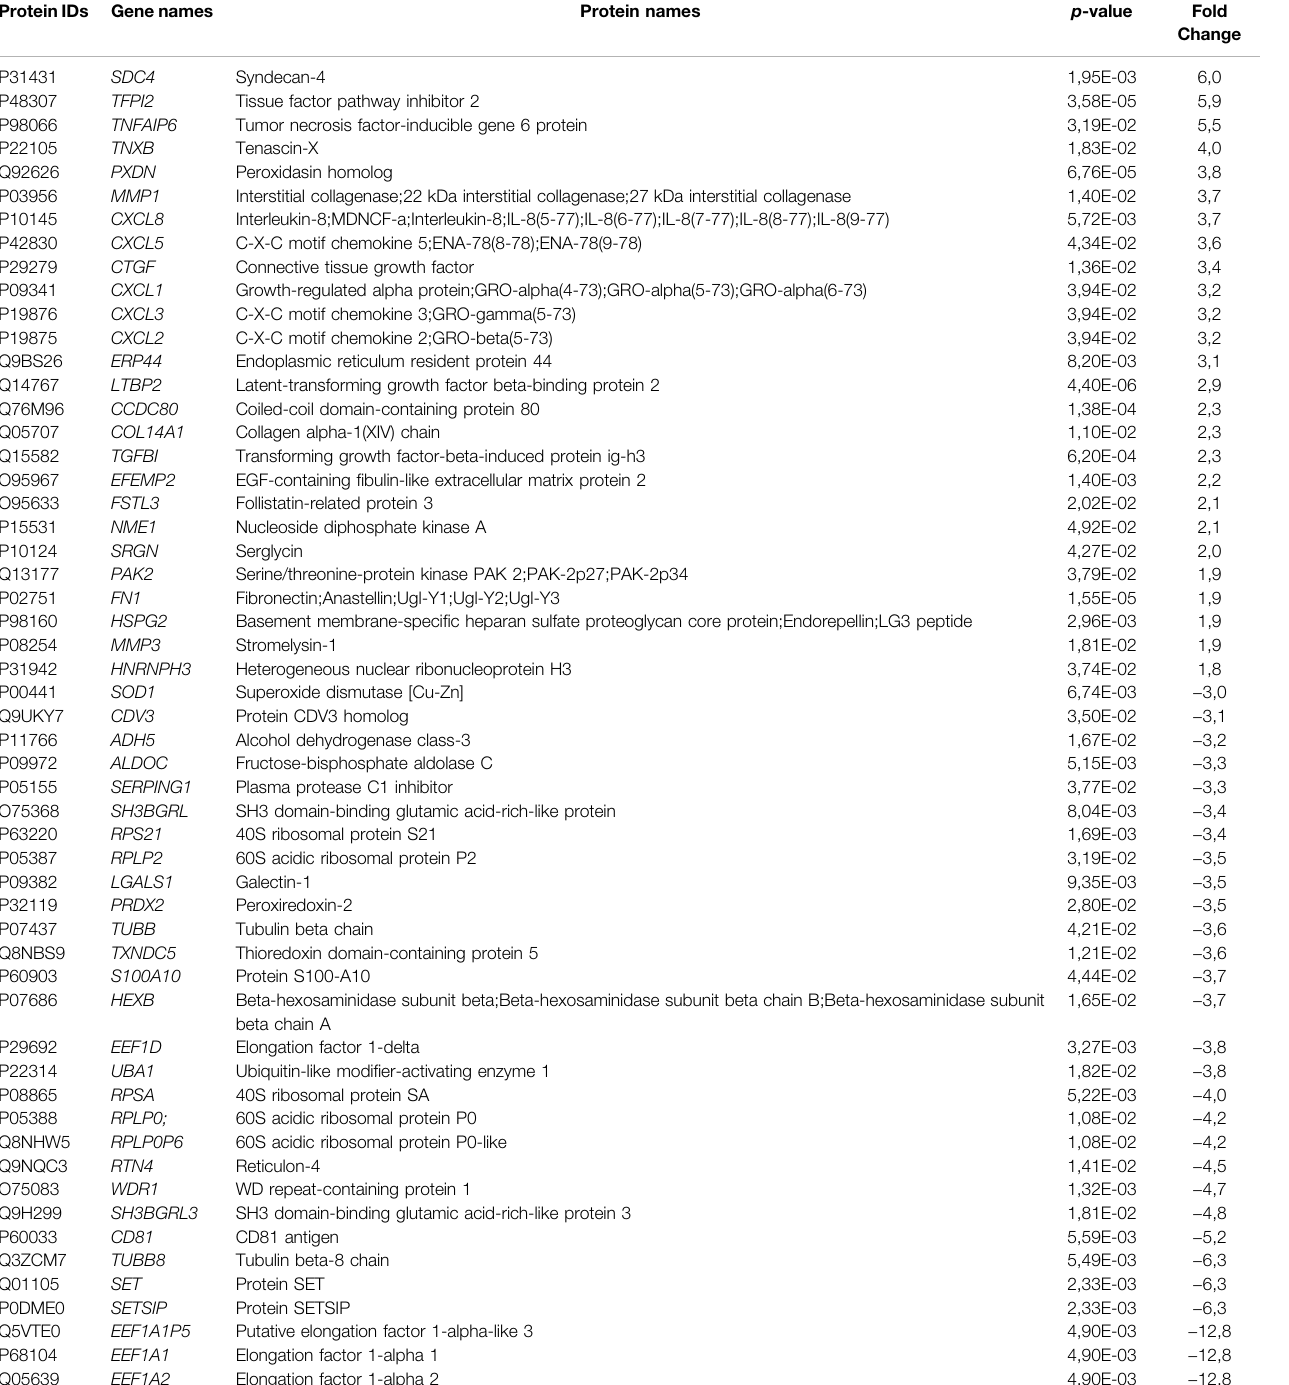
TABLE 2 | List of top 50 differentially secreted proteins induced by electrical pulse stimulation (EPS protocol 1). ProteinIDs Gene